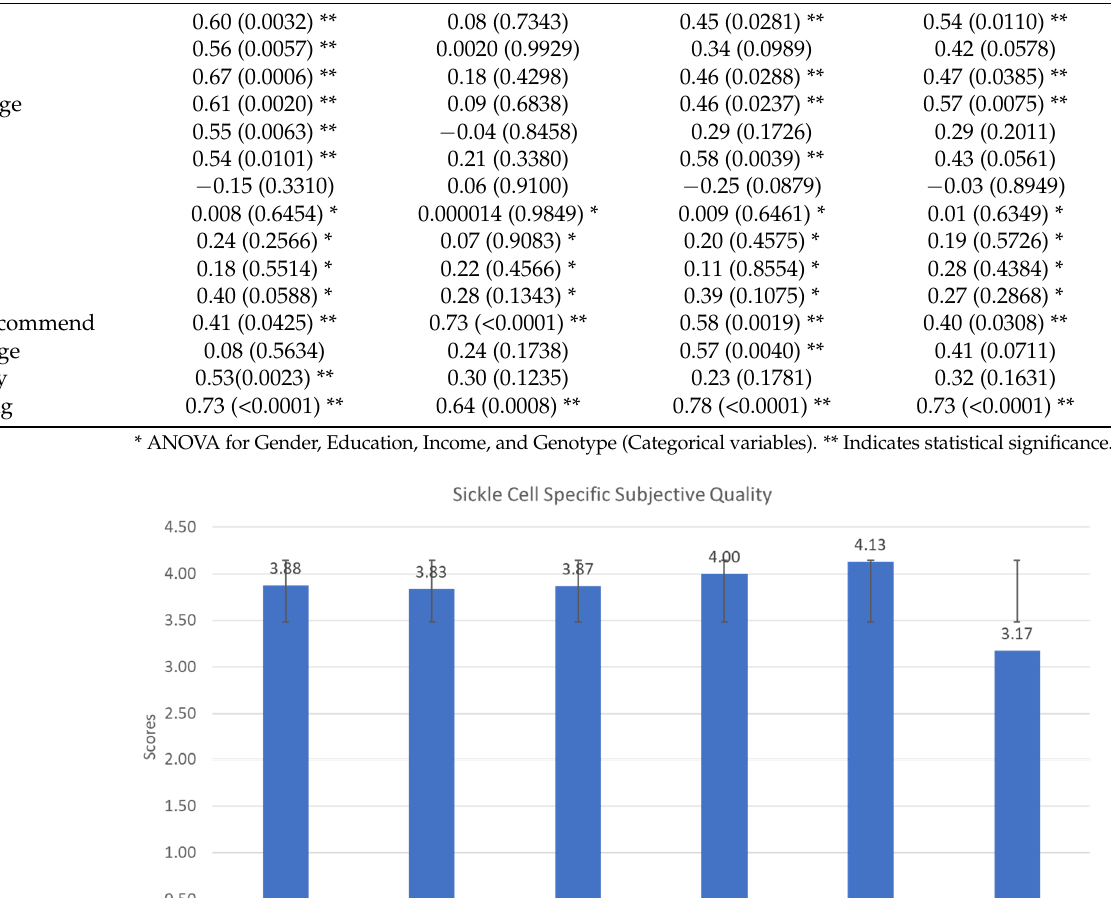
Figure 4. Application subjective quality ratings.